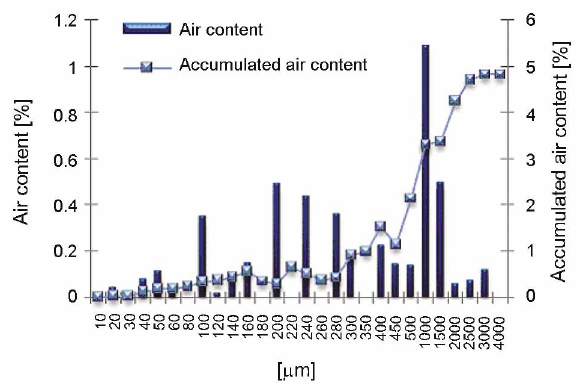
Fig. 2. Air void content according to its size in non air-entrained SCC investigated according to EN 480-11 (2006) (CEM II 32.5